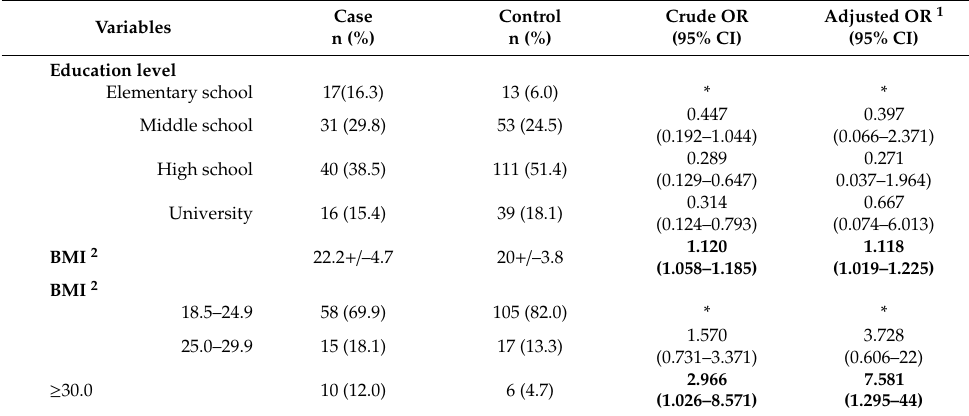
Table 2. Odds ratio (ORs) and 95% Confidence Interval (CI) of thyroid cancer risk